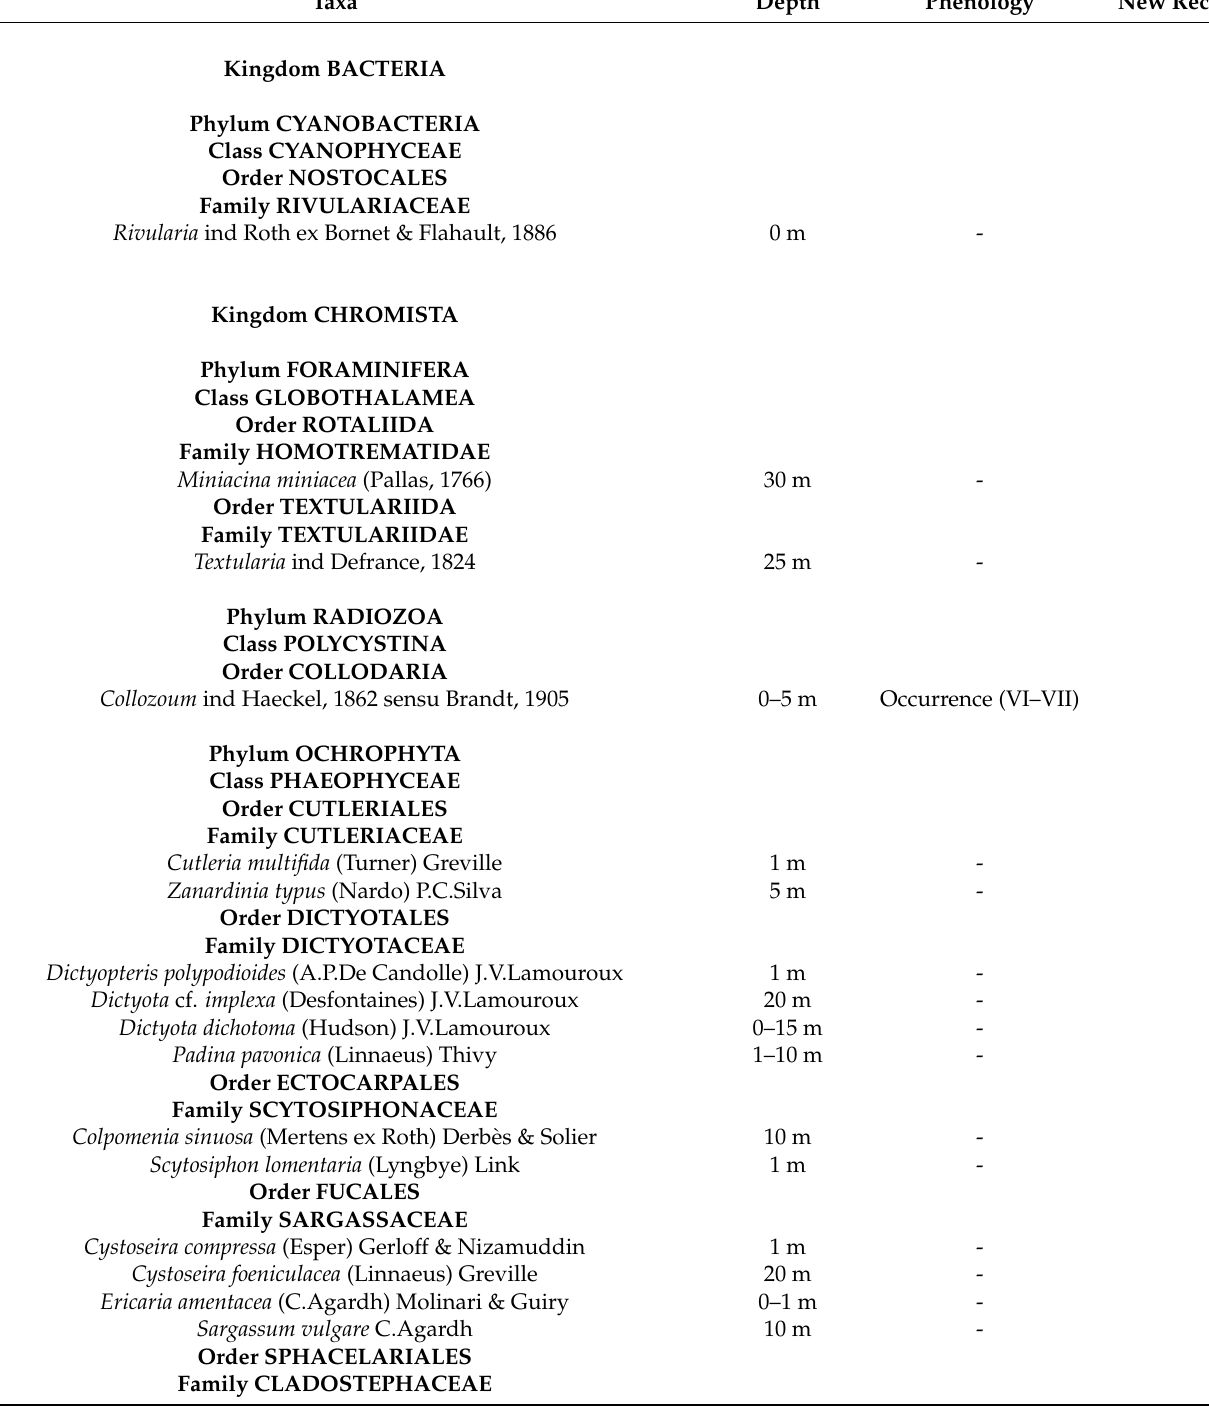
Table 1. Complete list of marine species found during the project “Biodiversity MARE Tricase” with indication of depth or depth range (when multiple specimens were found) at which taxa were recorded during this study. For phenology, Rep. behav., reproductive behaviour; Rep. structures, reproductive structures. In the column New Record, * indicates a new record for the Ionian Sea, ‡ indicates that the only other record in the Ionian Sea is from the Messinian Strait, † indicates the easternmost record in the Mediterranean Sea, # indicates new species for science. For the records that were already reported in a separate publication, the reference is given at the end of the species